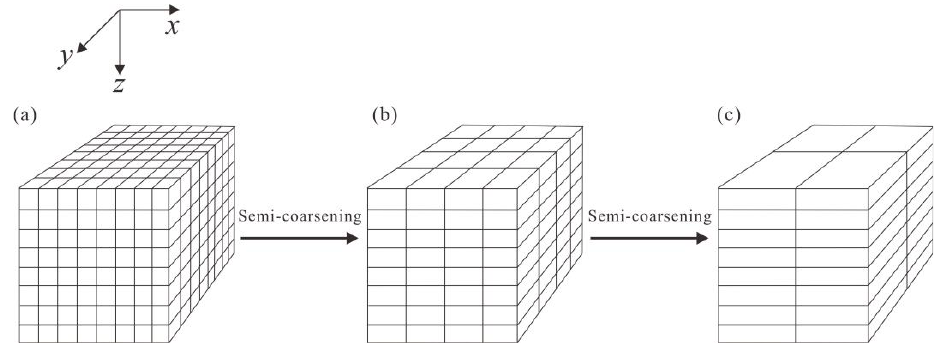
Figure 2. Semi-coarsening scheme. ( a ) Grid of size 8 × 8 × 8; ( b ) grid of size 4 × 4 × 8; ( c ) grid of size 2 × 2 × 8. The diagram shows the process of two semi-coarsening, the first semi-coarsening changes grids from 8 × 8 × 8 to 4 × 4 × 8, the second semi-coarsening changes grids from 4 × 4 × 8 to 2 × 2 × 8. Semi-coarsening is only performed on grids in x - and y -direction, while the grids in z -direction remain unchanged.